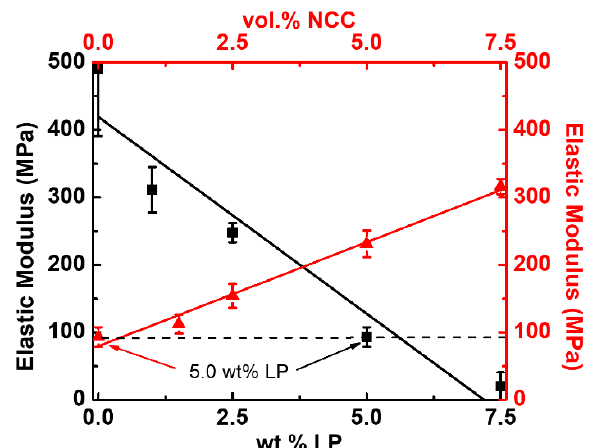
Figure 3. Elastic modulus trending for increasing lithium perchlorate (LP) (black curve with squares, elastic modulus vs. content of LP for PEO–LP) and NCC vol.% (red curve with triangles, elastic modulus vs. content of NCC for PEO with 5.0 wt.% LP) concentrations.